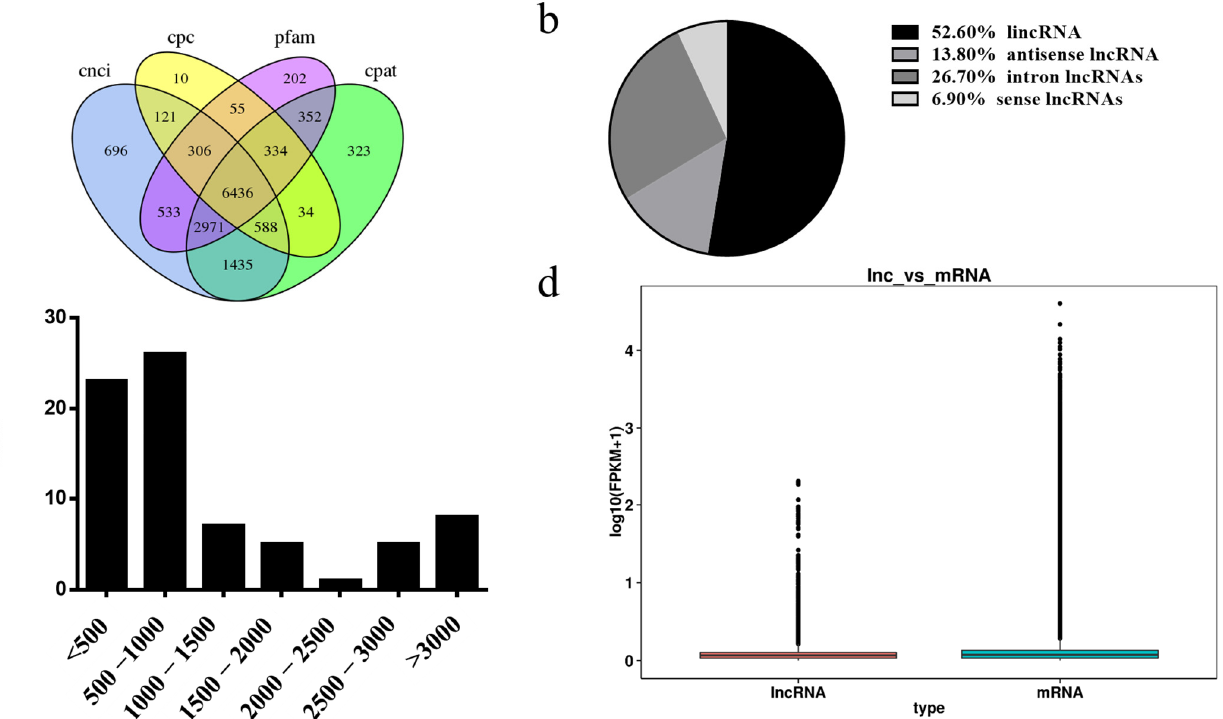
Figure 4. Identification of differentially expressed lncRNAs. ( a ) Expression of up- and downregu- lated lncRNAs in the NC and BLM groups, as determined by RT–PCR. ( b ) KEGG pathway analysis of differentially expressed lncRNAs. Significant differences are represented with *( p < 0.05) and **( p < 0.01). 3.5. Differentially Expressed circRNA Identification